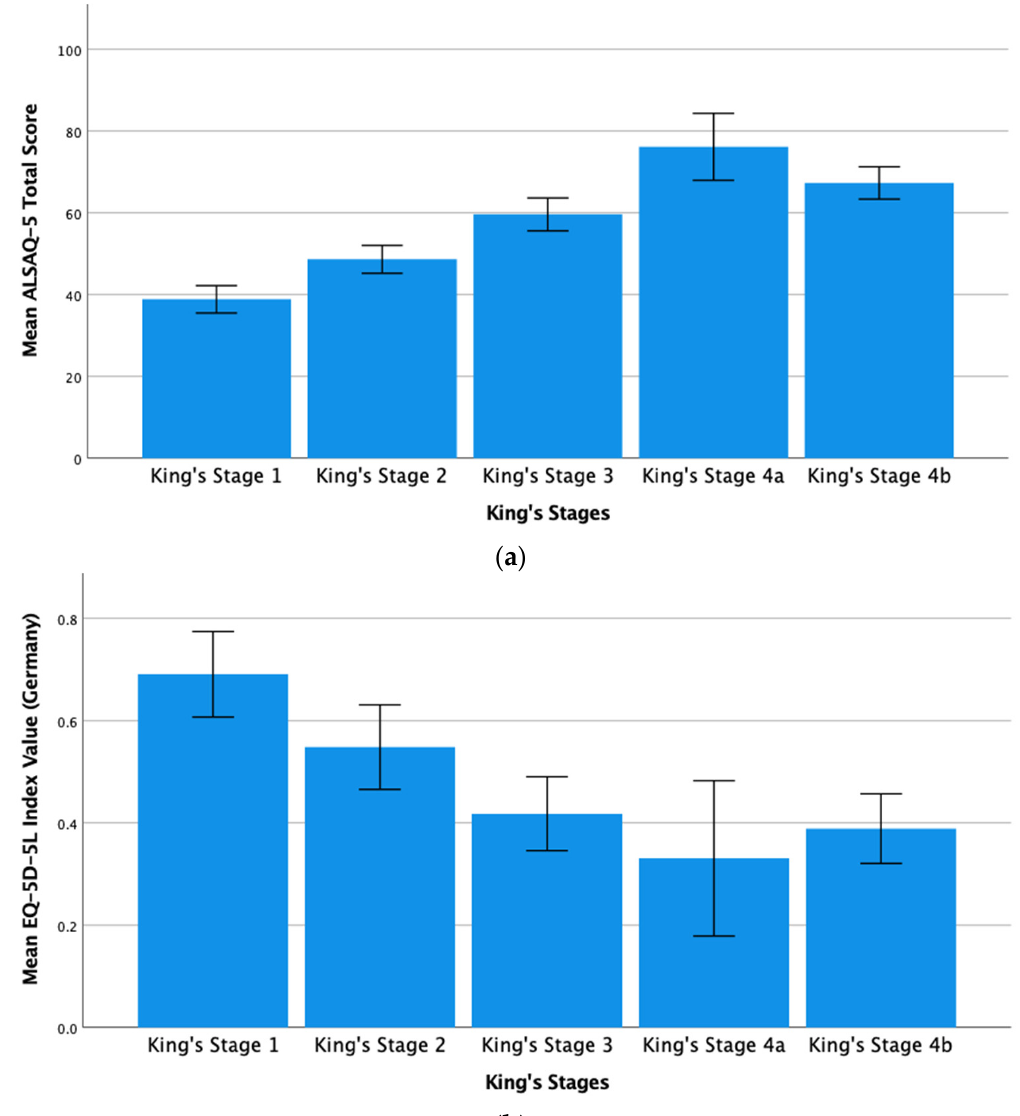
Figure 3. ( a ). Mean ALSAQ-5 total score on the basis of King’s stages. ( b ). Mean EQ-5D-5L index value (Germany) on the basis of King’s